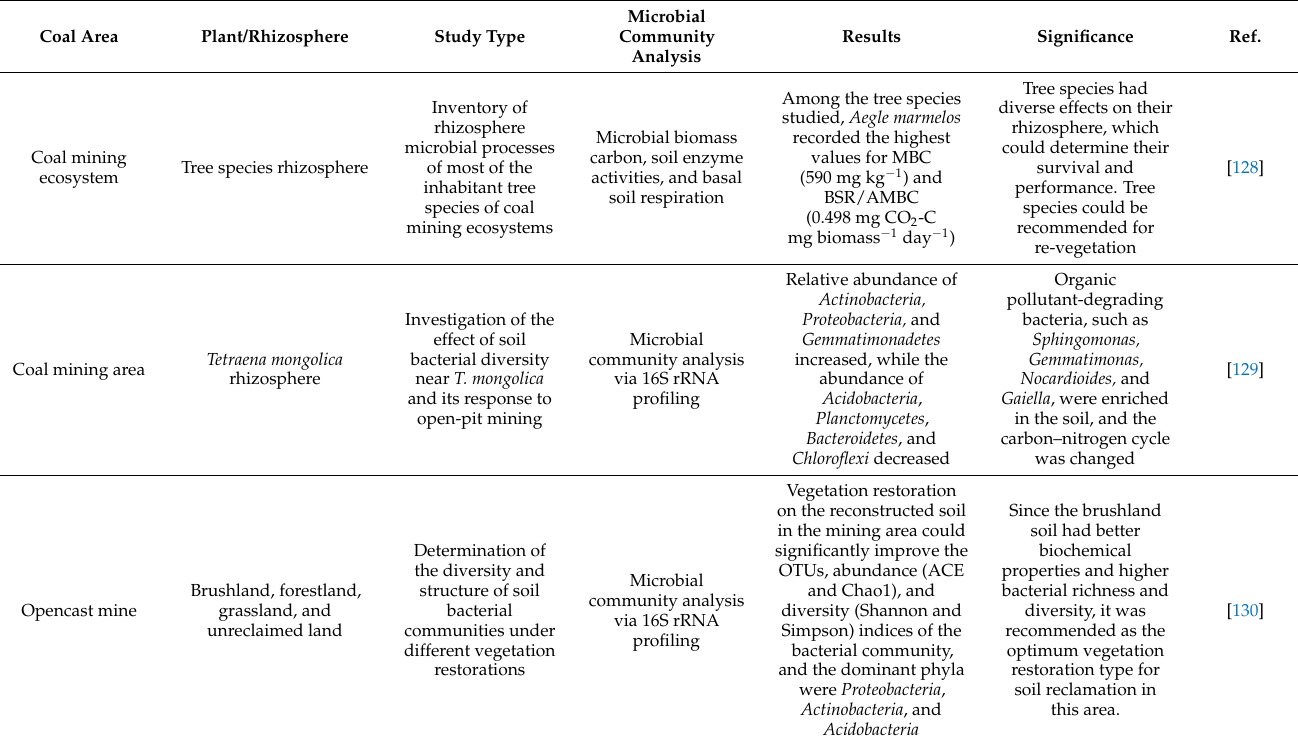
Table 4. Culture-dependent and independent approaches used to study the active microbial com- munity for soil development and biogeochemical cycling to ensure the sustainability of established plants in mining areas